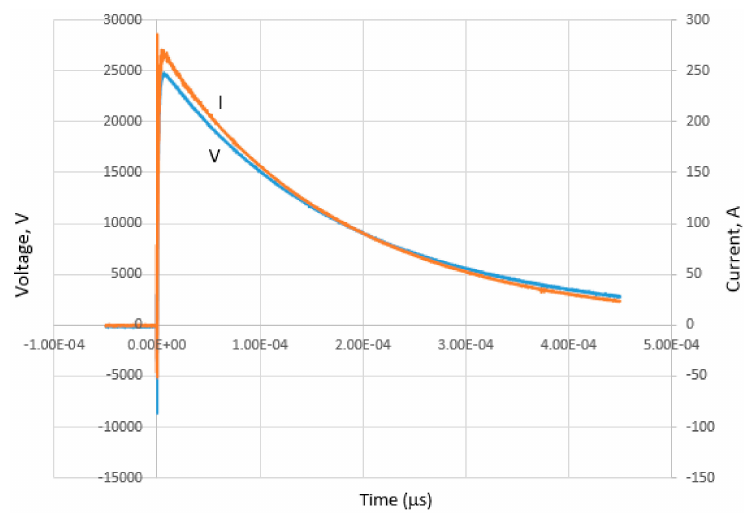
Figure 21. Voltage and current traces of 2-rod, at a charging voltage of 30 kV.